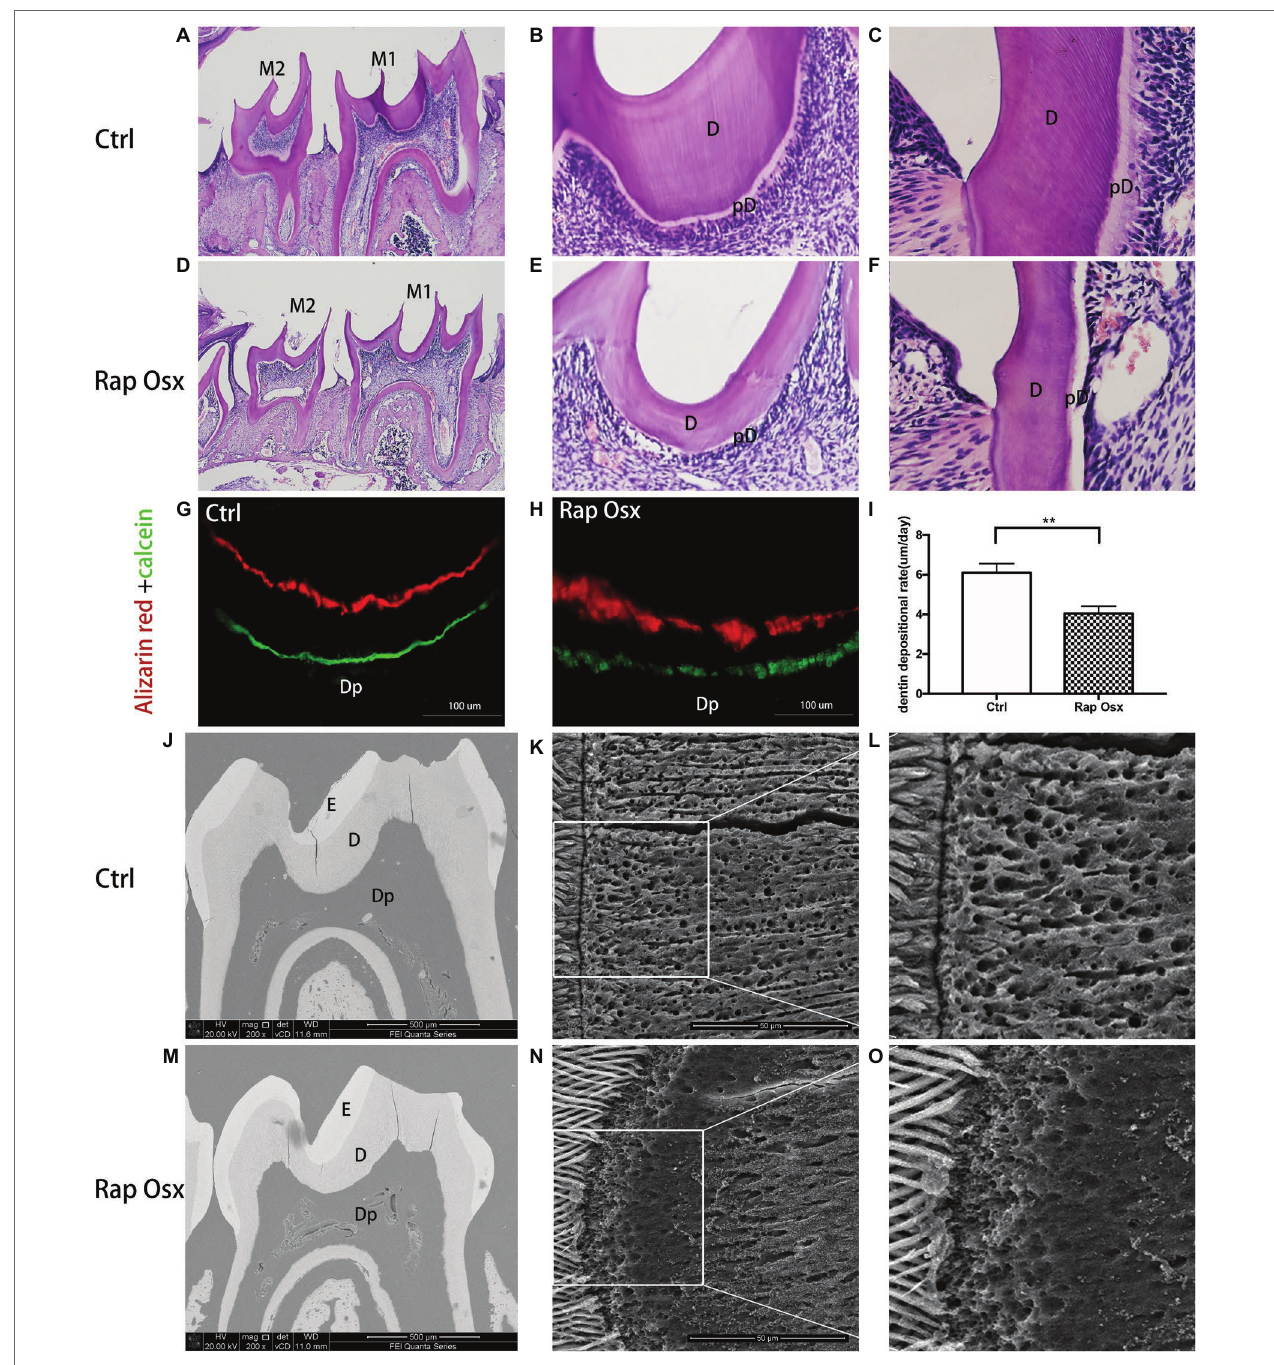
FIGURE 2 | Analyses of the tooth tissue, dentin mineralization level and dentinal tubular structures of Rap-Osx mice. (A–F) HE staining of the mandibular first molars from Ctrl mice and Rap-Osx mice. Mature dentin and predentin were both thinner in Rap-Osx mice than in the control group, while the pulp chambers were enlarged in Rap-Osx mice. (G–I) Alizarin and calcein double fluorochrome labeling was performed to determine the dentin apposition rate of 4-week-old control and mutant mice. Mice were first injected with calcein (green). Two weeks later, they were injected with Alizarin red (red). Representative images were captured of the mandibular first molar dentin region at the position of the middle sagittal and coronal section. The distance between these two labels represented the dentin matrix deposited over a period of 14 days. The labels for the mutant mice were thinner (Scale bars = 100 μ m). Statistical analyses of the dentinogenesis rate were performed. (J–O) Backscattered scanning electron microscopy images show the enamel in white, dentin in gray, and low mineral-density areas in black. The mutant molars had irregular dentin with several black/dark areas (M), indicating the hypomineralization of mutant molars. (K,L) Resin-casted and acid-etched scanning electron microscopy analyses of the dentinal tubules of Ctrl mice. (N,O) Resin-casted and acid-etched scanning electron microscopy analyses of the dentinal tubules of mutant mice. E, enamel; D, dentin; pD, predentin; Dp, dental pulp. Note that the dentinal tubules of the Raptor cKO mice were unevenly distributed. Scale bars = 50 μ m. Data represent mean ± SD (** p <